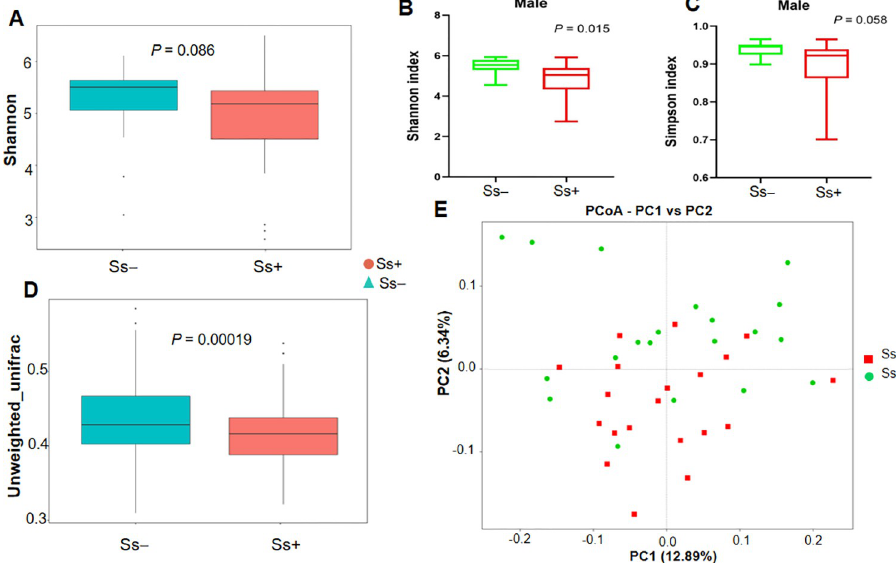
Fig 2. Comparison of alpha diversity indexes and beta diversity in CKD patients with and without S . stercoralis infection. (A) Shannon index (B) Shannon index in males (C) Simpson index in males. (D) Boxplot based on unweighted UniFrac distance. (E) Principal coordinate analysis